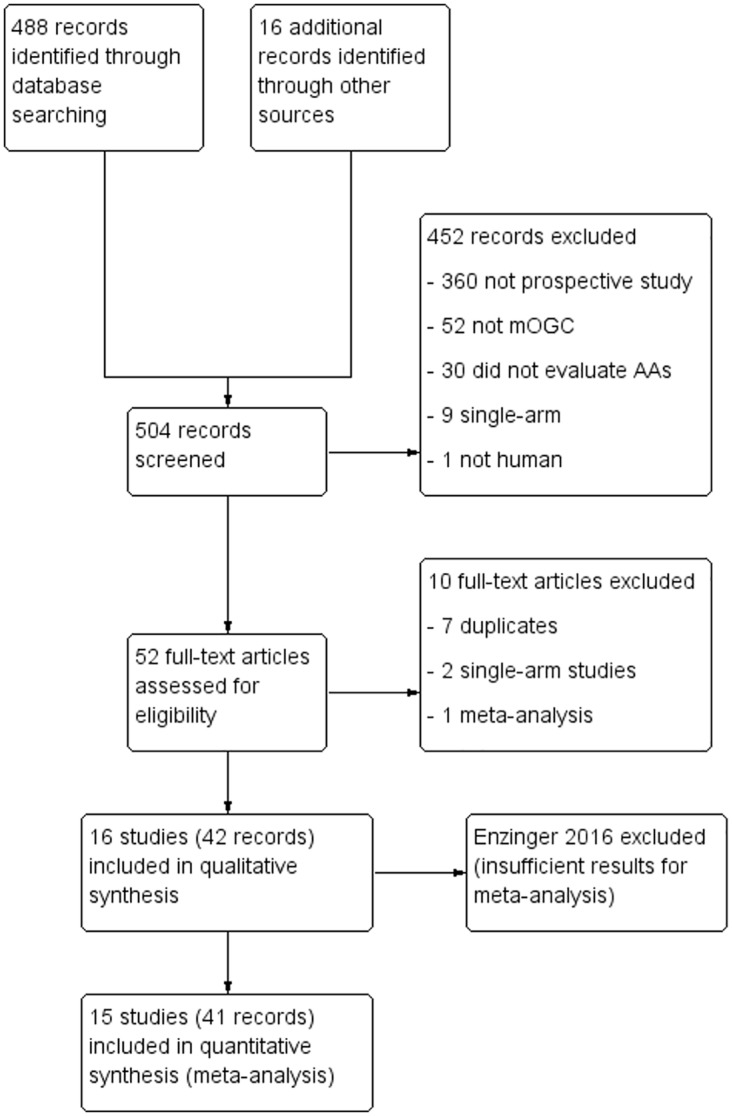
Study flow diagram.